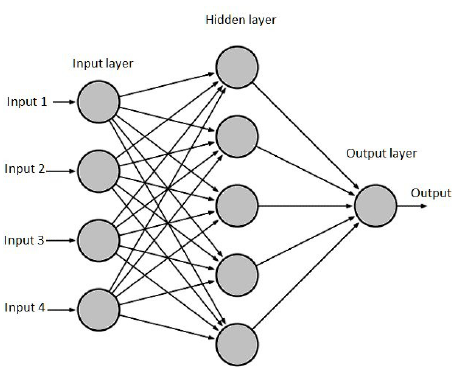
Figure 2. Multi-layer perceptron.